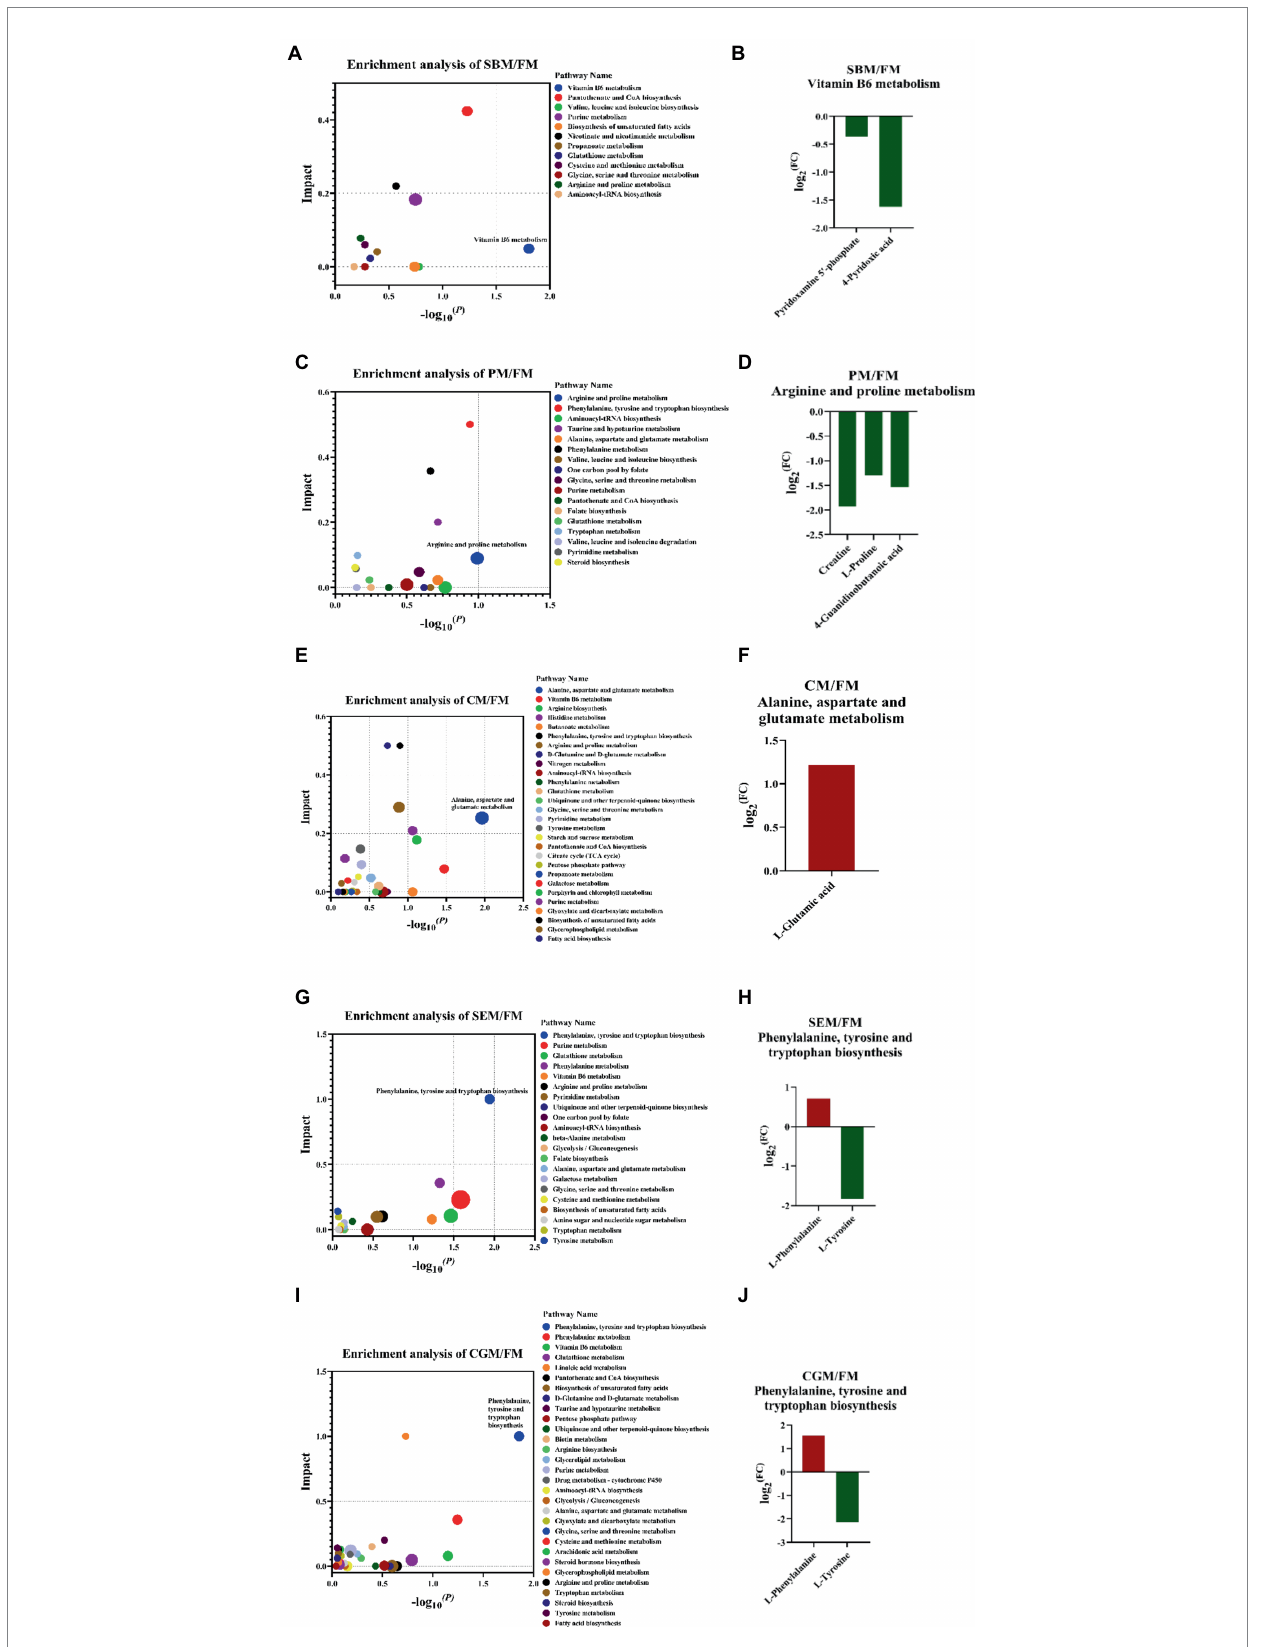
FIGURE 5 The bubble diagram exhibited the enriched KEGG pathways of differential metabolites in SBM vs. FM (A) , PM vs. FM (C) , CM vs. FM (E) , SEM vs. FM (G) , and CGM vs. FM (I) . Different colors represent different metabolic pathways, and the diameter of the circle represents the number of metabolites enriched in this pathway. The bidirectional bar chart exhibited the fold changes of metabolites in the most significantly affected (largest −log 10 P value) metabolic pathways (B,D,H,F,J) . Red columns indicate an increase in metabolites, and green columns indicate a decrease in